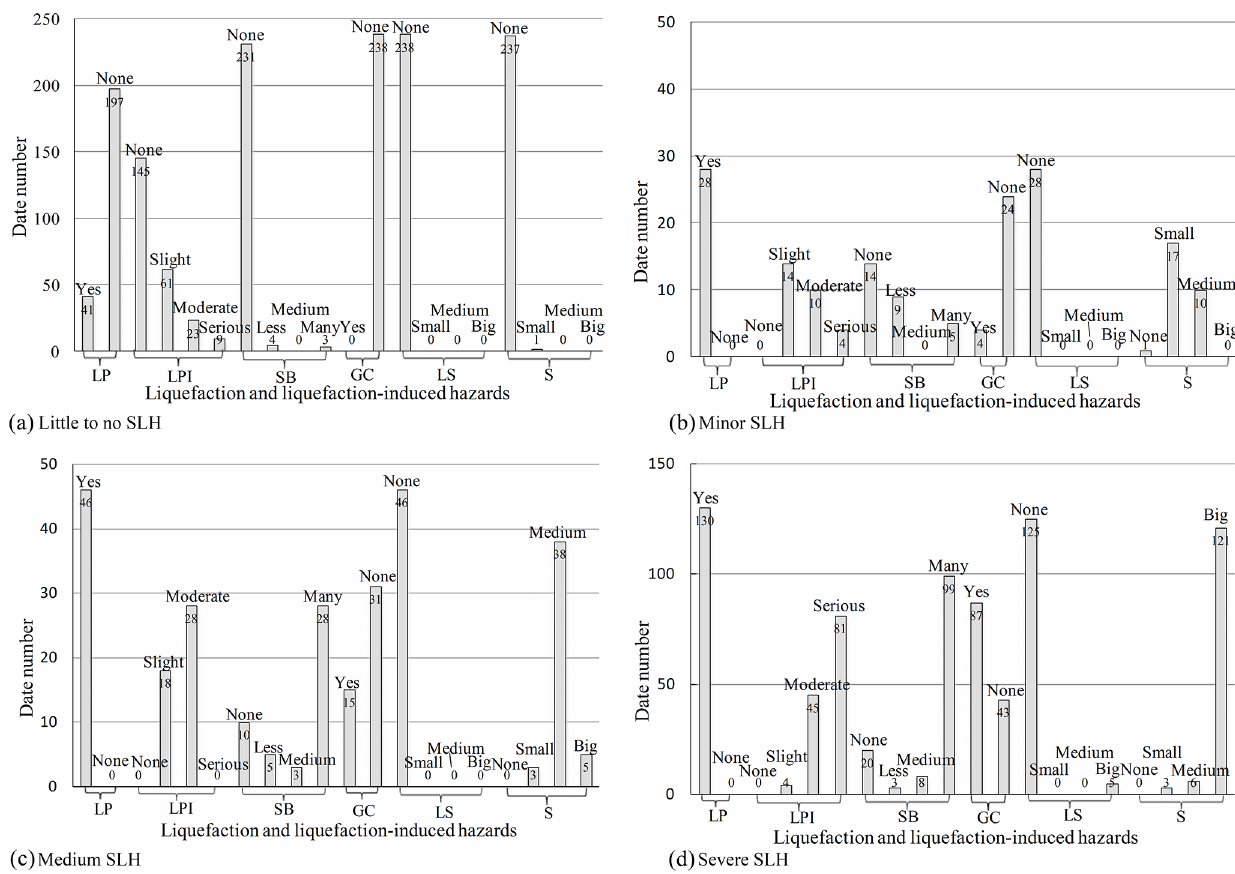
Figure 7. Statistical summary of seismic liquefaction-induced hazard data.